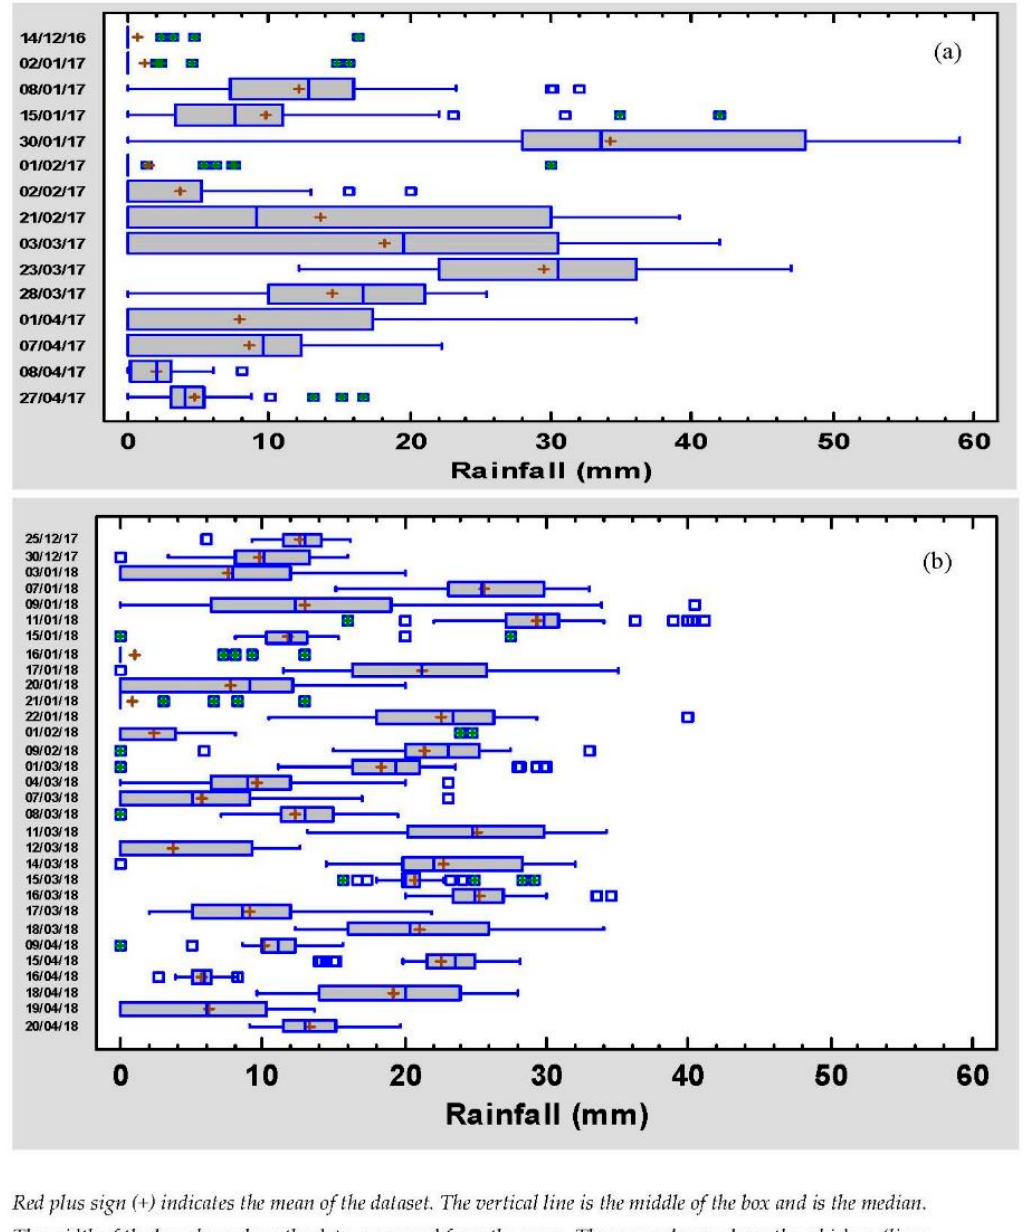
Figure 5. Distribution of daily rainfall (mm) in ( a ) SES1 and ( b )